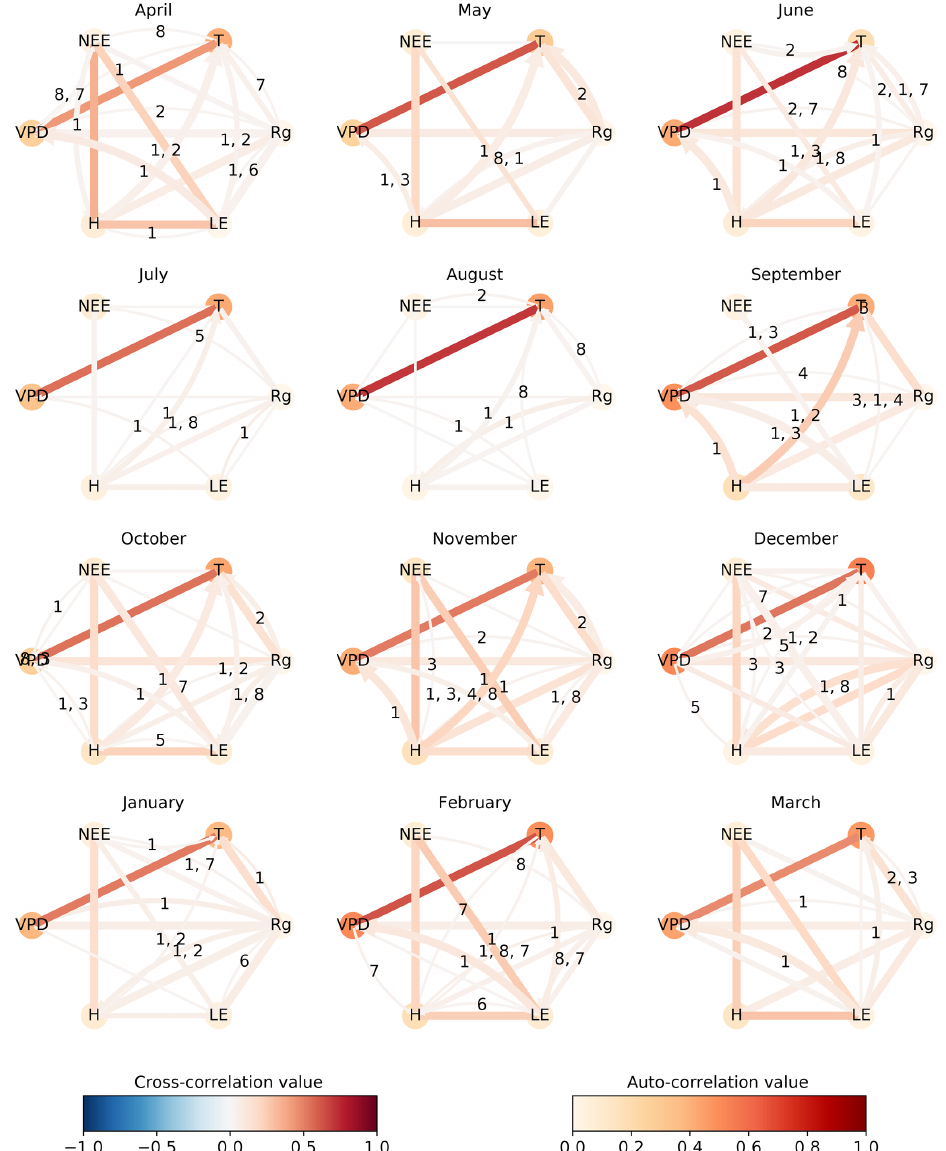
Figure A8. The same as Fig. 5, but the analysis was performed using a non-linear independence test. The number of significant occurrences of a link is given by its width. The link strength, given by the link colour, is calculated by averaging the significant links of the towers. The link’s lag is shown in the centre of each arrow, sorted in descending order of link strength. The resulting graphs are shown for April 2014 till March 2015. The significance threshold is 0.01. Note that GPDC only yields positive link strengths. Further, the strength values estimated with GPDC are rather weak due to the low number of datapoints and the larger sensitivity of that method to the sample